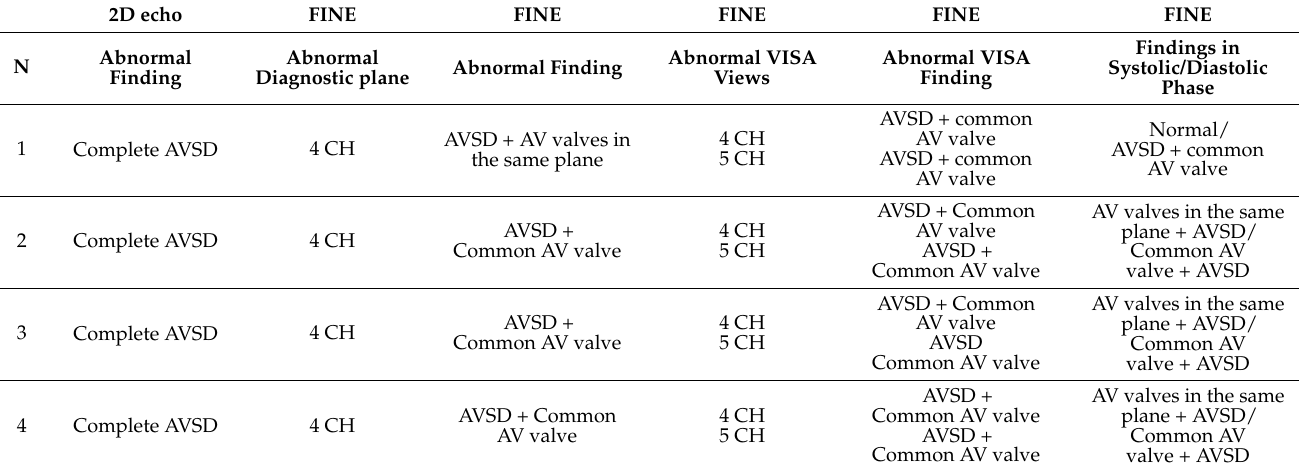
Table 2. Abnormal findings from the 2D echocardiography and after using FINE (both in the diagnostic planes and after VIS-Assistance) and the different findings during systolic and diastolic phases.